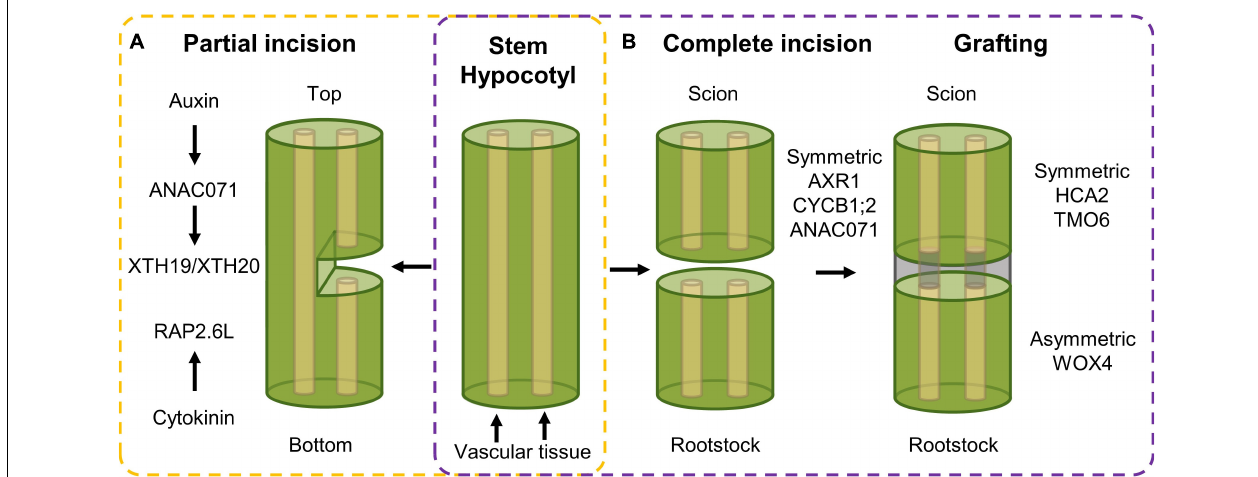
FIGURE 2 | Transcriptional response following (A) partial incision in stem tissue and (B) complete incision and following tissue reuniting. (A) Upon partial incision of the inflorescence stem, a different response in the top versus bottom side of the cut can be observed. In the top, auxin accumulation activates expression of ANAC071 , that in its turn induces the XTH19 and XTH20 cell wall modifying genes, that, in combination with cytokinin-dependent RAP2.6L expression in the bottom side, ensure vascular tissue reconnection. (B) Complete incision results in an induction of auxin-related, cell division and wound healing genes, being AXR1 , CYCB1;2 and ANAC071 , respectively, in both scion and rootstock. Following grafting, symmetric and asymmetric responsive genes, being HCA2 and TMO6 , and WOX4 , respectively, facilitate tissue reconnection in the